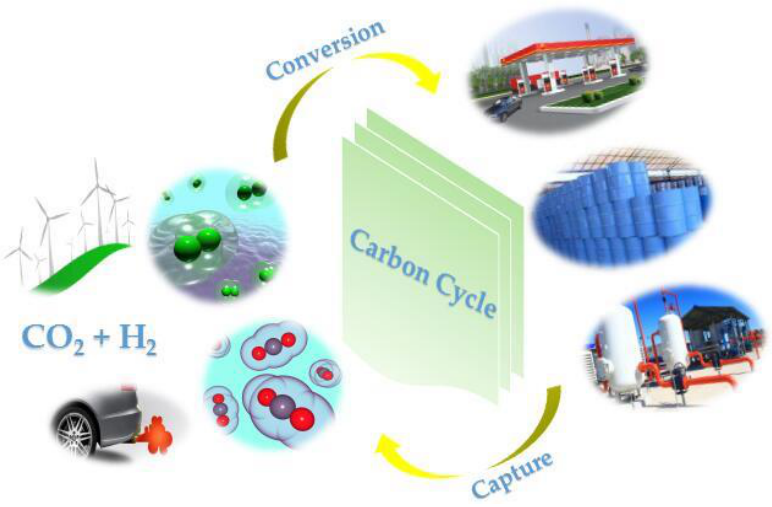
Figure 25. CO 2 conversion into fuels, which release CO 2 again upon burning, aiming a closed carbon cycle.